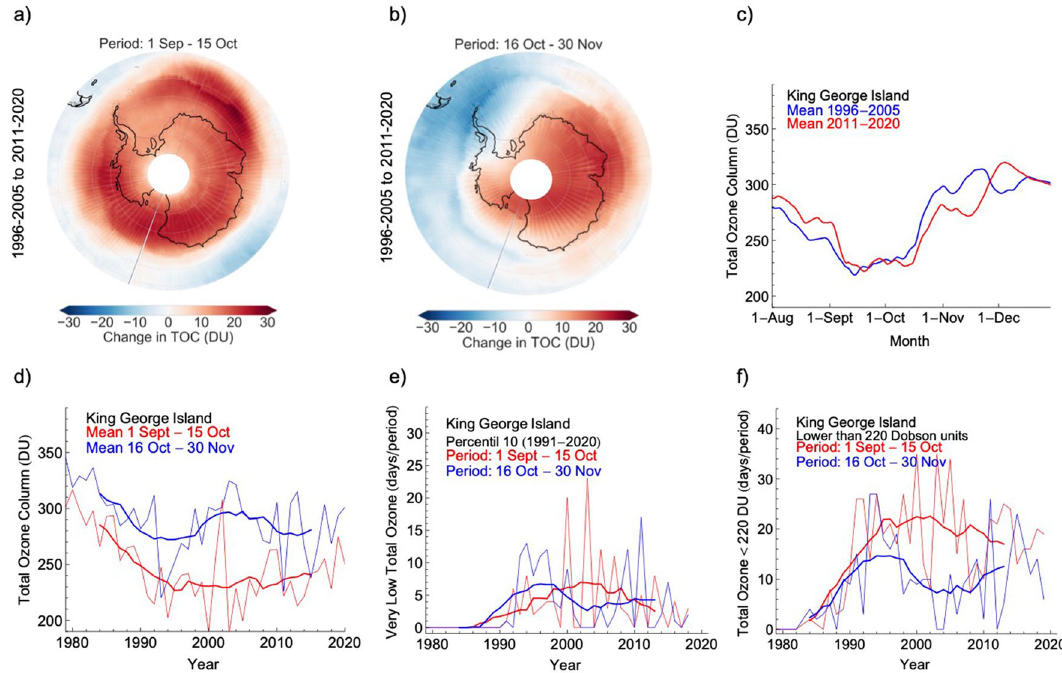
Figure 2. The persistently low values of the total ozone column in late spring favor extremes of UV radiation over the Antarctic periphery. ( a ) Changes from 1996–2005 to 2011–2020 in Antarctic total ozone column (TOC) values averaged from 1 September to 15 October. ( b ) Changes from 1996–2005 to 2011–2020 in Antarctic TOC values averaged from 16 October to 30 November. ( c ) Daily estimates of the TOC values over King George Island averaged over two periods: 1996–2005 (blue line) and 2011–2020 (red line). ( d ) Progress of TOC values averaged from 1 September to 15 October (red line) and from 16 October to 30 November (blue line). ( e ) Number of days with “very low” TOC values (defined according to the 10th percentile) counted over two periods: from 1 September to 15 October (red line) and from 16 October to 30 November (blue line). ( f ) Number of days with TOC values lower than 220 Dobson units (DU) counted over two periods: from 1 September to 15 October (red line) and from 16 October to 30 November (blue line). Bold lines in plots ( d – f ) show 11-year centered moving averages. Data from the TOMS instrument on the Earth Probe satellite and from the OMI instrument onboard the Aura satellite were used in plots ( a , b ). Data from the Multi Sensor Reanalysis (MSR2) were used in plots ( c – f ). The plots were generated using Python’s Matplotlib library 71